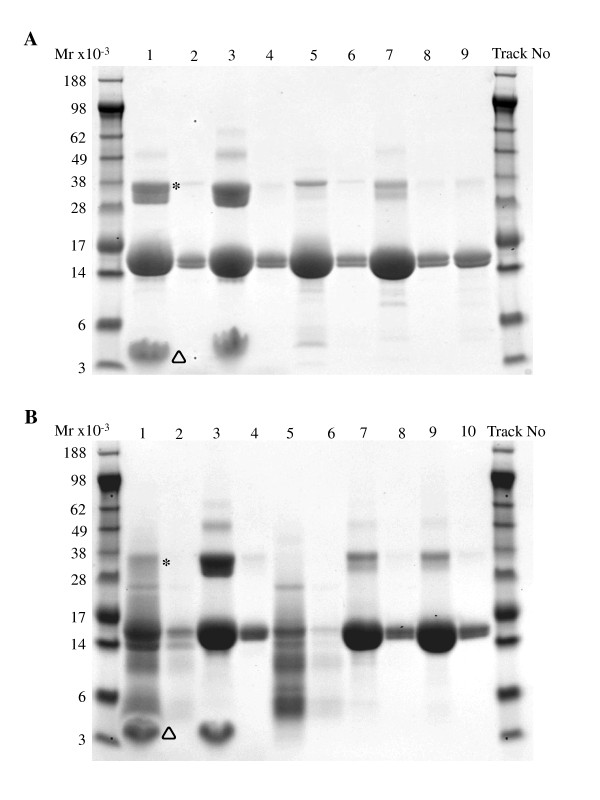
Characterization of blg digesta. A) phase 1 digestion: Lane 1 BLG @ 5 mg/ml, +PC (phosphatidyl choline) +E (enzyme). Lane 2 BLG @ 0.5 mg/ml, +PC +E. Lane 3 BLG @ 5 mg/ml, +PC -E. Lane 4 BLG @ 0.5 mg/ml, +PC -E. Lane 5 BLG @ 5 mg/ml, -PC +E. Lane 6 BLG @ 0.5 mg/ml, -PC +E. Lane 7 BLG @ 5 mg/ml, -PC -E. Lane 8 BLG @ 0.5 mg/ml, -PC -E. Lane 9 BLG @ 5 mg/ml. B) phase 1+2 digestion: Lane 1, BLG @ 5 mg/ml, +PC (phosphatidyl choline) +E (enzyme). Lane 2 BLG @ 0.5 mg/ml, +PC +E. Lane 3 BLG @ 5 mg/ml, +PC -E. Lane 4 BLG @ 0.5 mg/ml, +PC -E. Lane 5 BLG @ 5 mg/ml, -PC +E. Lane 6 BLG @ 0.5 mg/ml, -PC +E. Lane 7 BLG @ 5 mg/ml, -PC -E. Lane 8 BLG @ 0.5 mg/ml, -PC -E. Lane 9 BLG @ 5 mg/ml. Lane 10 BLG @ 0.5 mg/ml. Asterisk (*) denotes BLG SDS resistant dimmer, triangle (Δ) denotes Phosphatidyl choline.